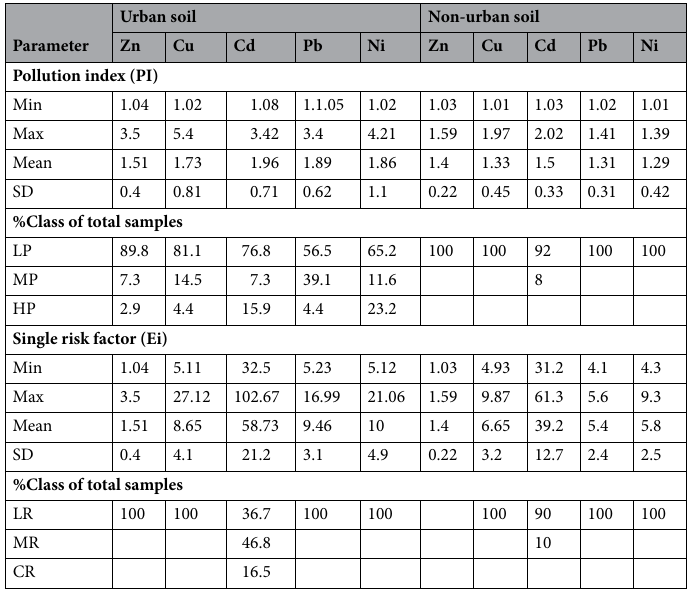
Table 3. The level and terminology of PI and Ei of the analyzed heavy metals in urban and non-urban soils. PI; LP low pollution (1 < PI ≤ 2), MP moderate pollution (2 < PI ≤ 3), HP high pollution (PI > 3). Ei; LR low risk (Ei ≤ 40), MR moderate risk (40 < Ei ≤ 80), CR considerable risk (80 < Ei ≤